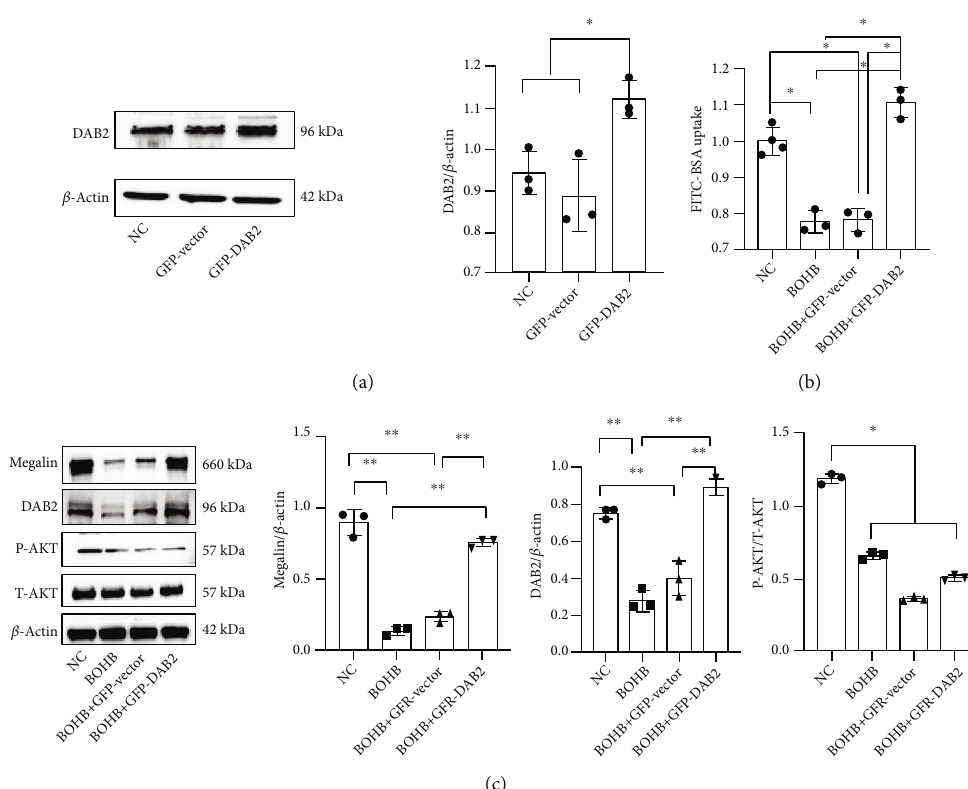
Figure 5: E ff ects of DAB2 overexpression on AKT/DAB2/megalin expression. (a) DAB2 level in HK-2 cells transfected with GFP-Vector or GFP-DAB2. (b) FITC-BSA uptake levels in HK-2 cells transfected with GFP-Vector or GFP-DAB2. (c) Megalin, DAB2, and AKT in HK-2 cells transfected with GFP-Vector or GFP-DAB2. BOHB, beta-hydroxybutyric acid; NC, normal control; GFP-DAB2, plasmid encoding DAB2; GFP-Vector, plasmid encoding control. Data are expressed as mean ± SD . ∗∗ Represents P < 0 : 01 ; ∗ represents P < 0 : 05